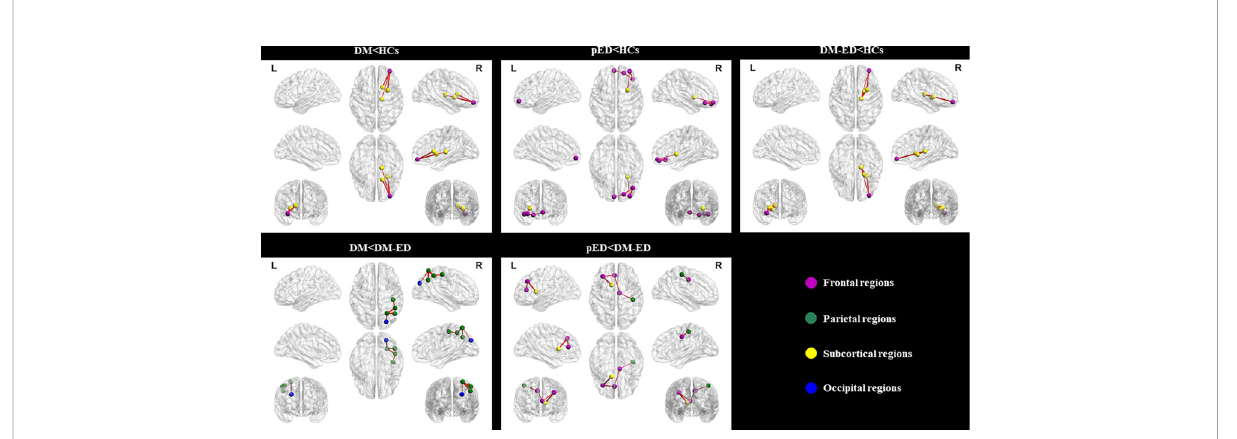
FIGURE 2 Subnetworks showing differences among the DM, pED, DM-ED, and HC groups using network-based statistical analysis. L, left; R, right; DM, diabetes mellitus; pED, psychogenic erectile dysfunction; DM-ED, diabetic erectile dysfunction; HCs, healthy